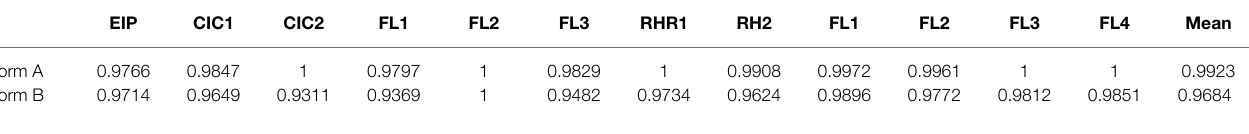
TABLE 5 | The reliability of cognitive